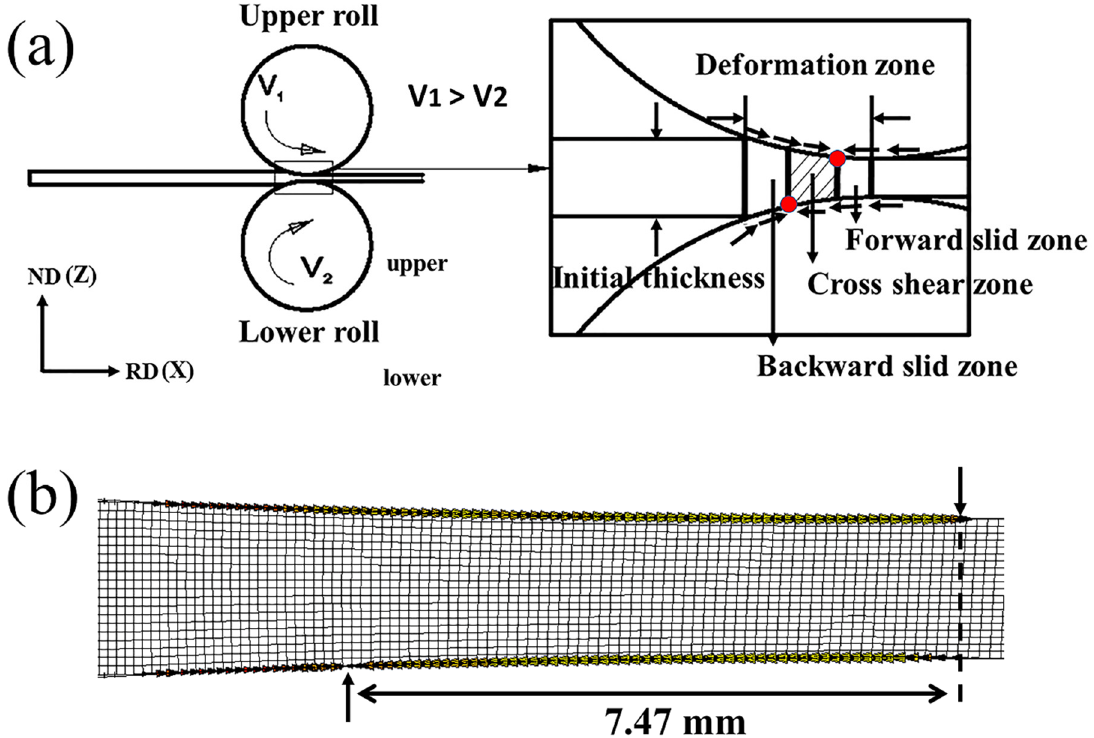
Figure 1. Schematic illustration and the finite element analysis of the asymmetric rolling (ASR). ( a ) Schematic of ASR deformation zone. ( b ) Distortions of rectangular grids predicted by the finite element analysis (FEA). The arrows indicate the locations of the neutral point at the upper and lower surfaces.